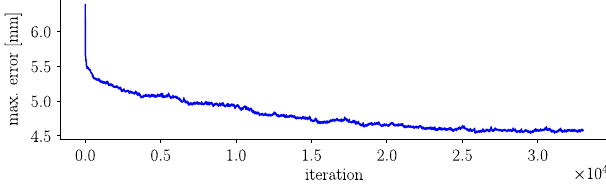
FIG. 18. Evolution of the l ∞ error between the measurement and simulation during the local search with the best individual obtained by the MOGA as the starting point. with j ∈ ½ 1 ; … ; M (cid:2) j indicates an l;u (cid:2)